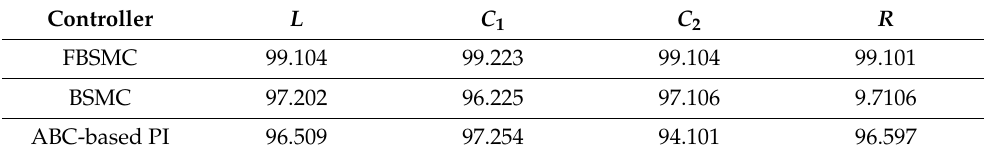
Table 7. Dynamic efficiency for a 20% decrease in the system